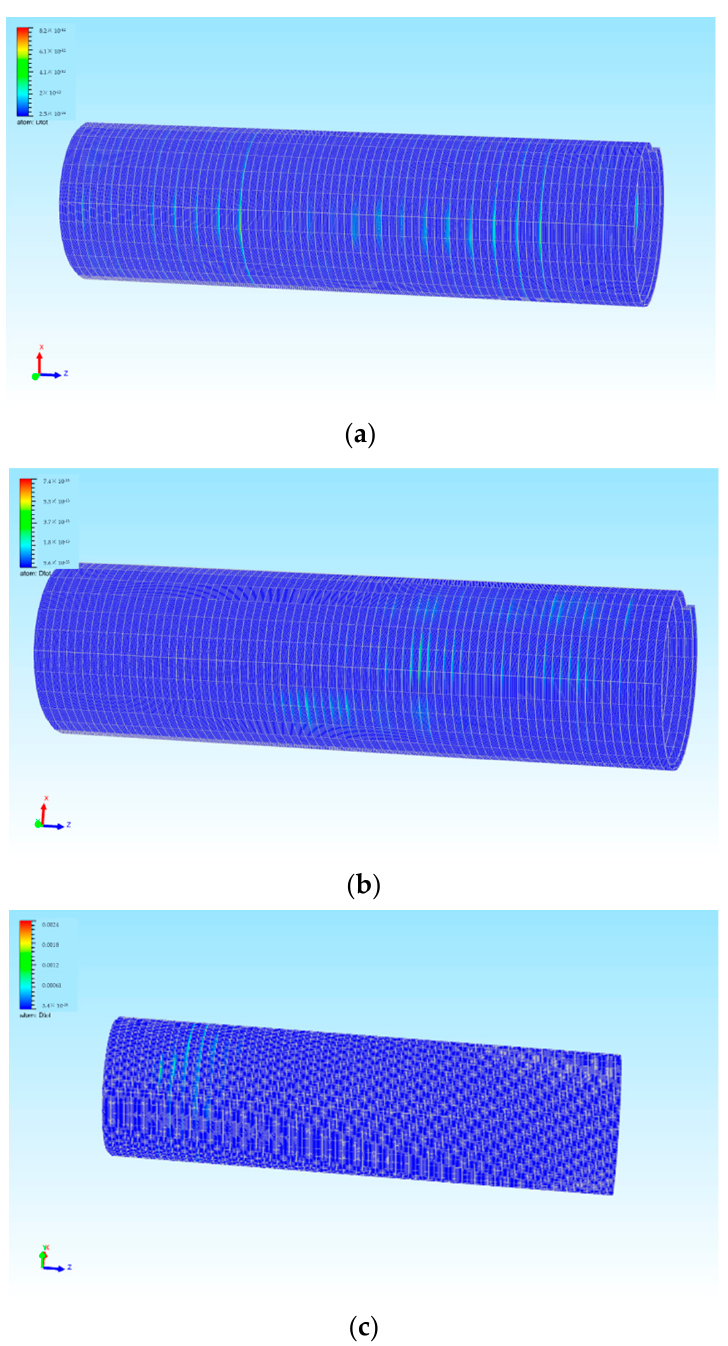
Figure 12. Fatigue damage of a compressive armor layer. ( a ) The fatigue damage nephogram under axial compressive load; ( b ) The fatigue damage nephogram under bending moment; ( c ) The fatigue damage nephogram under torsion.